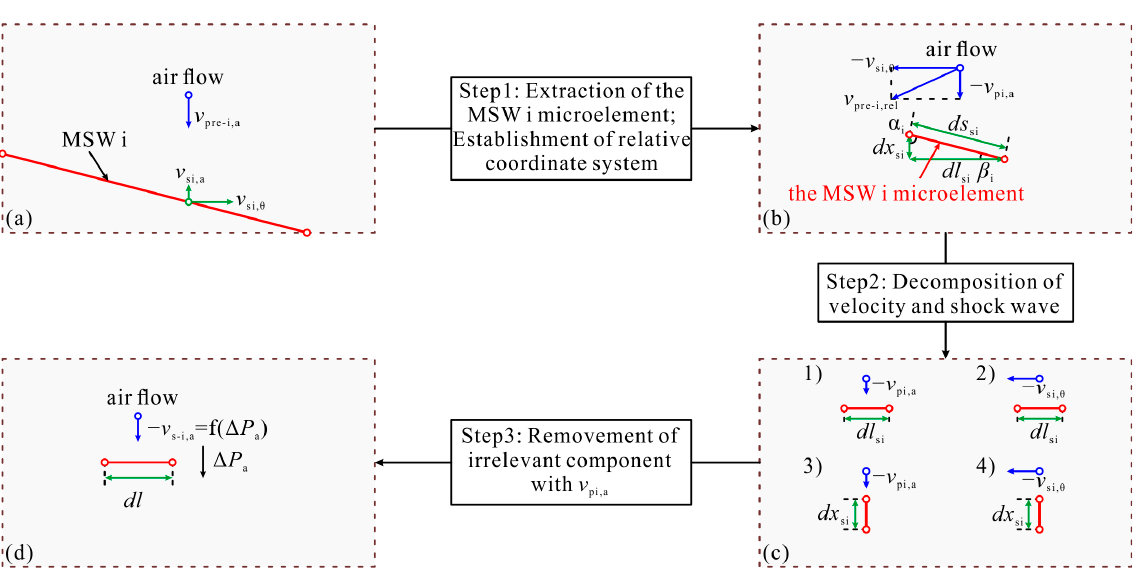
Figure 22. Sketch of the calculation method. ( a ) MSW i and the absolute velocity of air and MSW i. ( b ) the MSW i microelement and the relative velocity of air. ( c ) Components of the relative velocity and MSW i. ( d ) Relevant component with v pi,a .